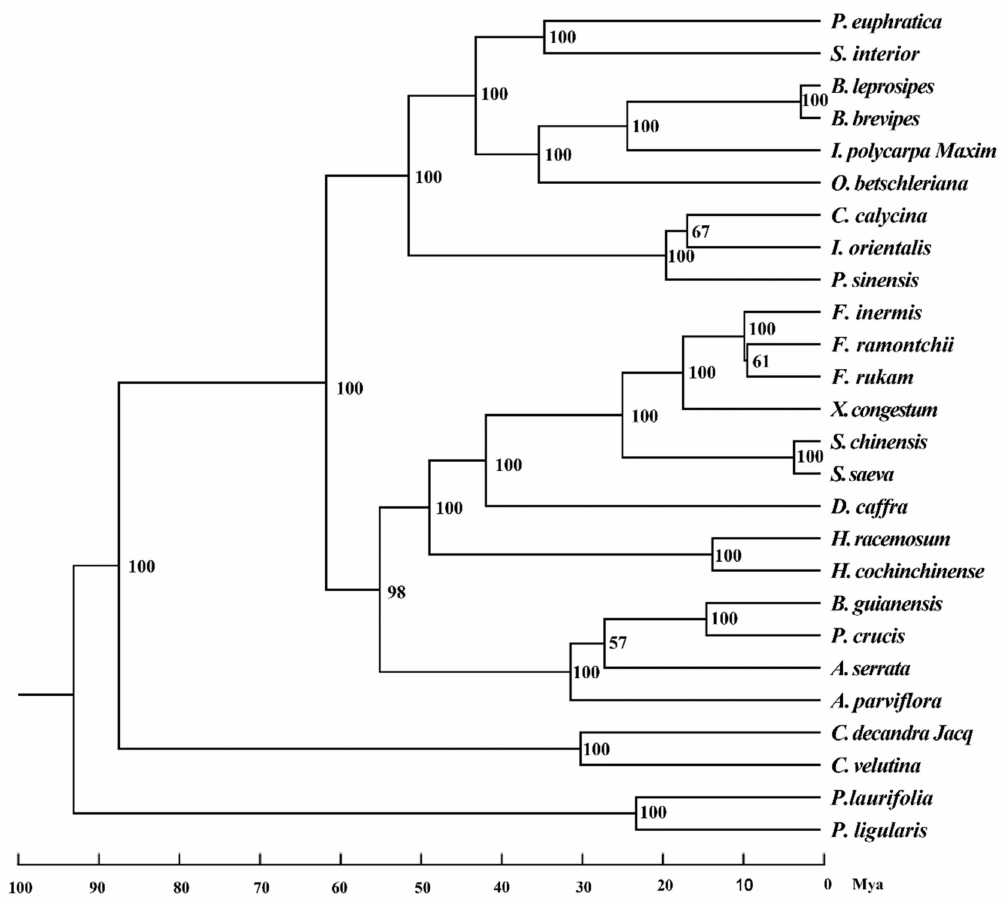
Figure 5. Phylogenetic tree of the 26 species based on 63 protein-coding genes using maximum likelihood (ML). Bootstrap values (1000 replications) between di ff erent genera are shown at the nodes. The branches are drawn in proportion to the posterior means of divergence times estimated under the GTR + I + G model with an independent relaxed clock and birth–death sampling, and the outgroup divergence constraint of 87 to 97